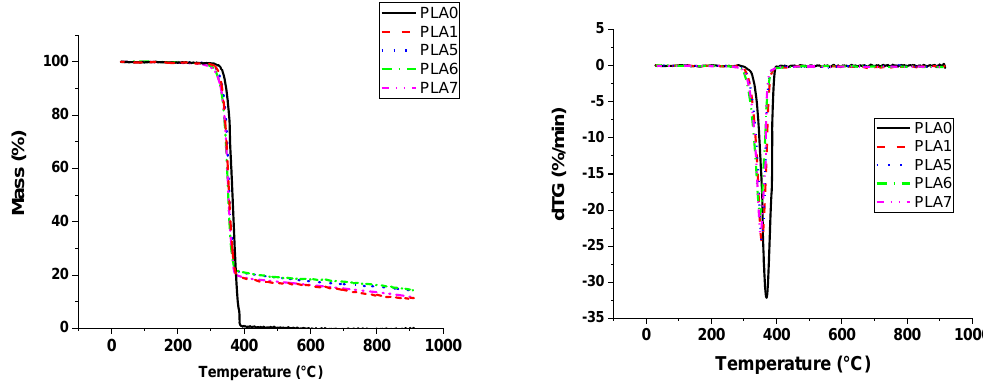
Figure 13. TG and dTG curves for PLA/APP/lignin composites.